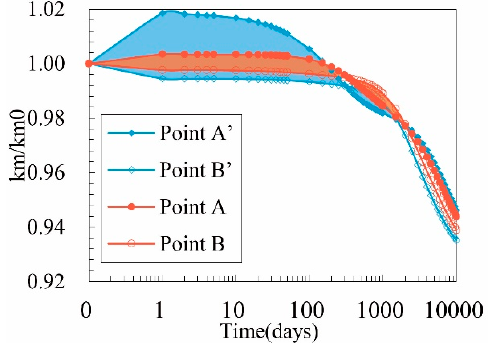
Figure 13. Evolution of matrix permeability at different points.